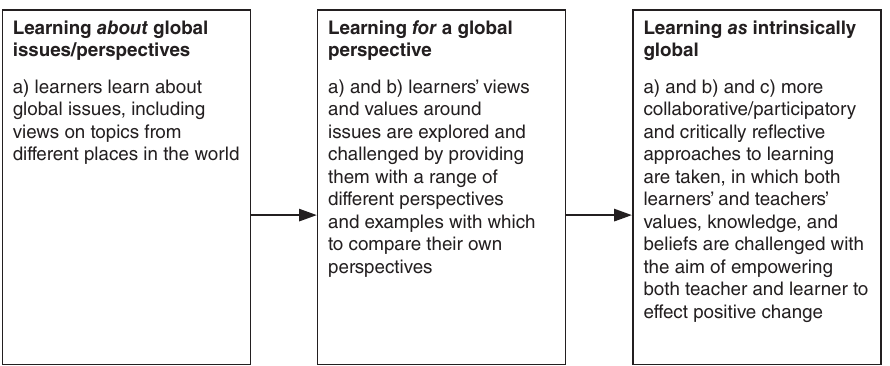
Figure 1: A continuum of global